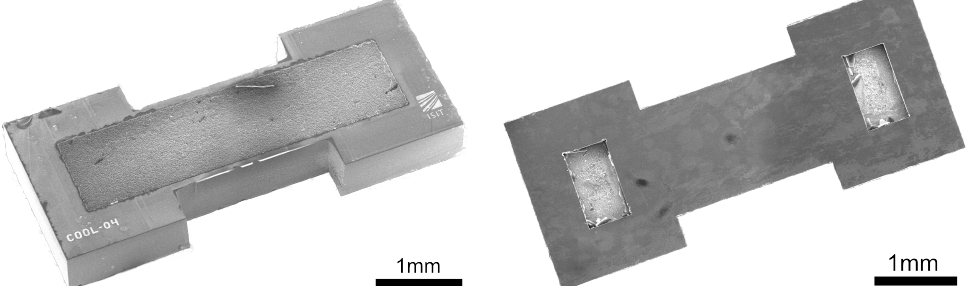
Figure 2. SEM micrographs of the top side ( left ) and the bottom side ( right ) of a finished silicon chip with embedded core and fluidic openings.